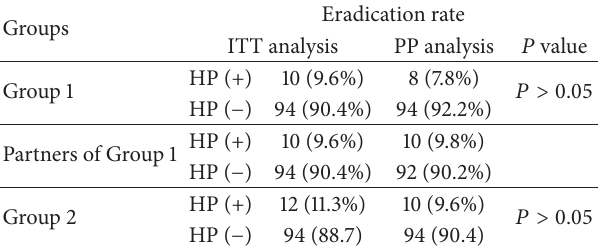
Table 2: Eradication rates of the